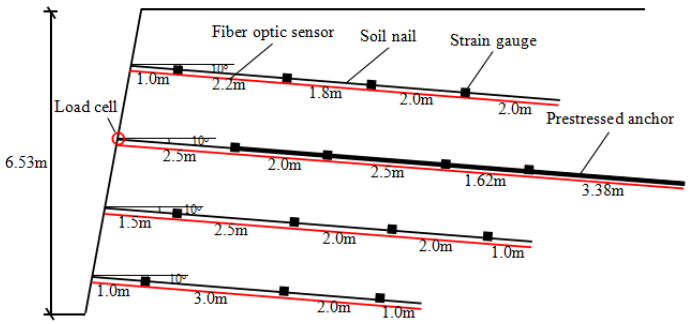
Figure 9. Location of instruments for testing set No. 4.